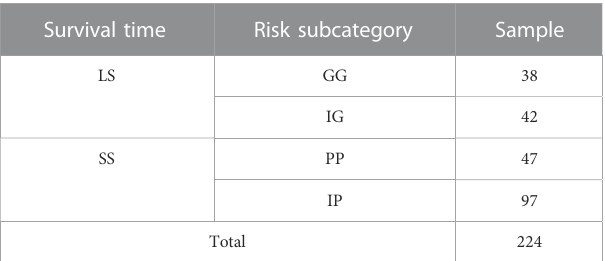
TABLE 1 The number of samples strati fi ed by survival time and risk subcategory.Good-Good(GG),Intermediate-Good(IG),Intermediate-Poor(IP), and Poor-Poor (PP) risk of AML sample. Long Survival (LS) and short survival (SS) terms.